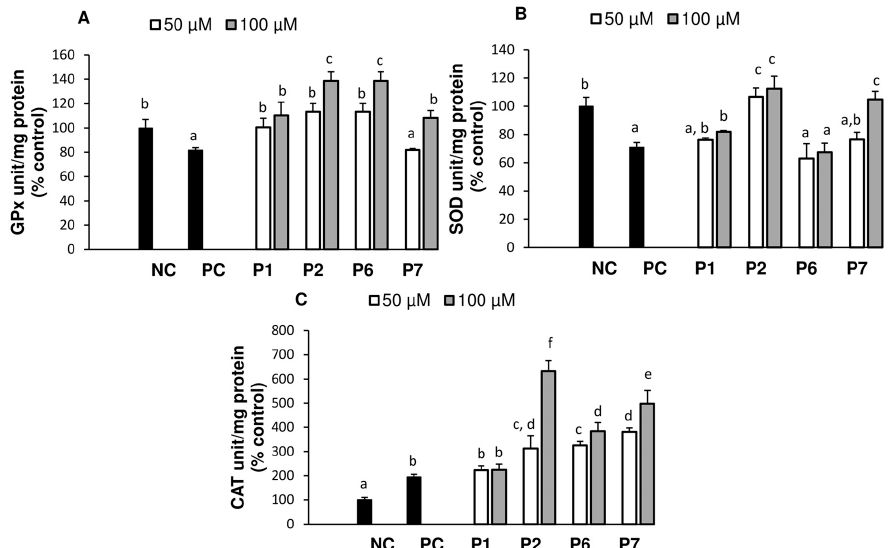
Figure 3. Effect of pre-treatment of AAPH-stressed HepG2 cells with peptides P2 and P4–P7 (0, 50 or 100 µ M) on the activity of glutathione peroxidase (GPx, A ), superoxide dismutase (SOD, B ), and catalase (CAT, C ). NC (negative control), PC (positive control). Data are expressed as means ( n = 3) ± SEM and significant differences ( p < 0.05, One-way ANOVA) in post-hoc Tukey’s Honest Significant Differences test are indicated by different